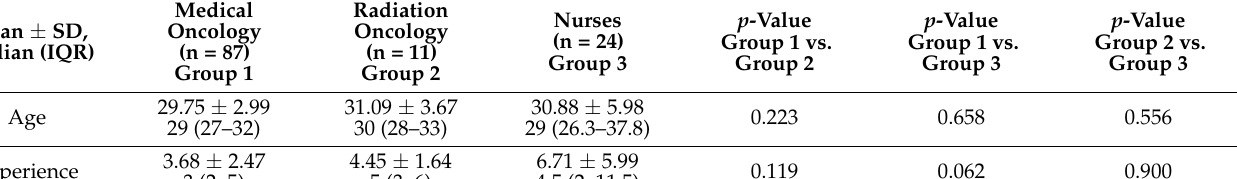
Table 3. Descriptive statistics of Burnout, COPE, and QoL, and comparisons between the